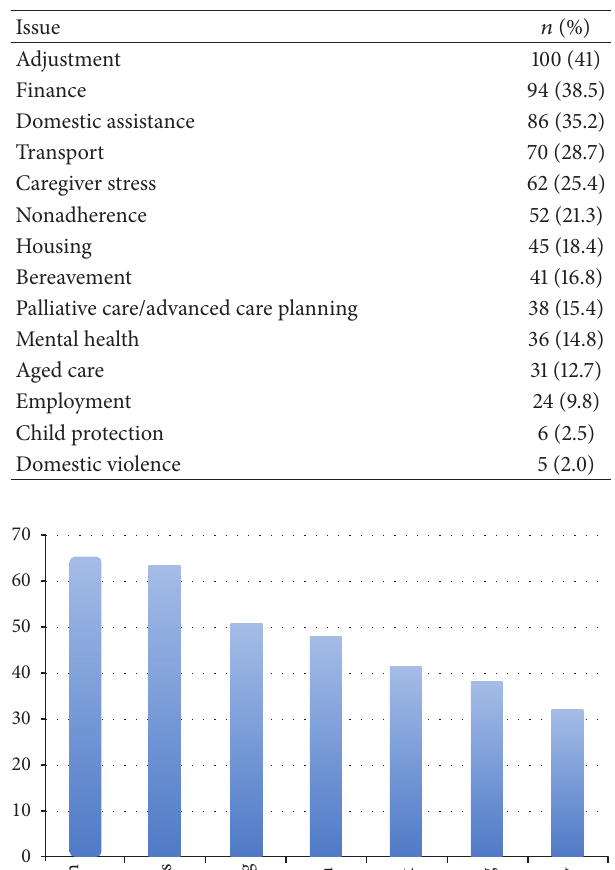
Table 1: Baseline characteristics of patients of CKD stage 5. Table 2: Social issues present in patients with CKD stage 5.